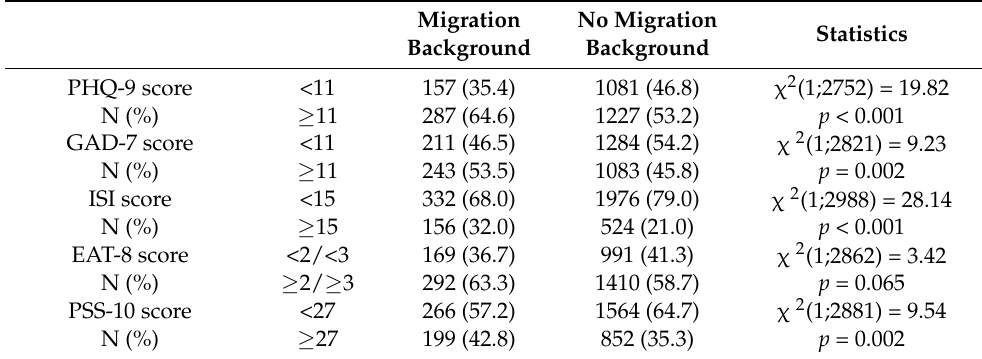
Table 4. Prevalence of moderate depressive symptoms, anxiety symptoms, clinical insomnia, eating symptoms, and high stress by migration status (whole sample, N = 3052).